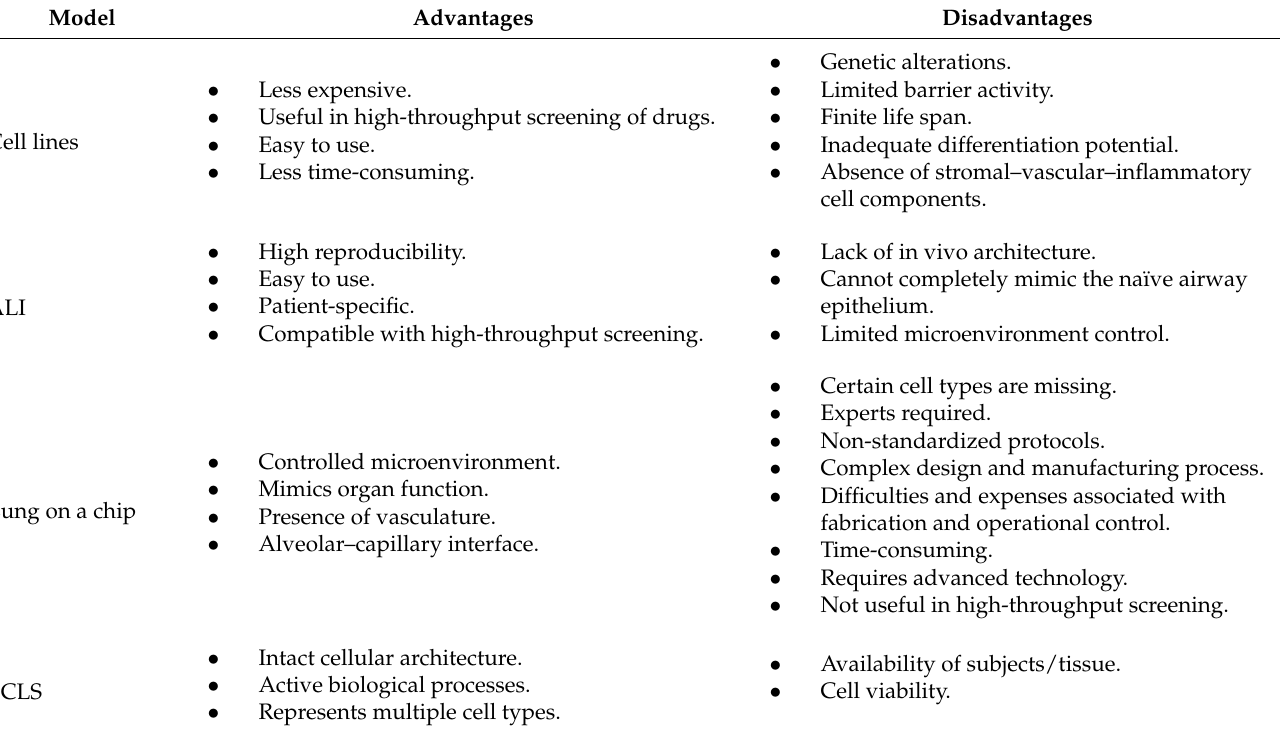
Figure 4. Models to study the effect of smoking on lung diseases: Types of different 2D in vitro (cell culture) , 3D in vitro (Spheroids, ALI, and lung-on-a-chip), ex vivo (PCLS, organoids), and in vivo (animal) models to study the effect of smoking on lung disease pathophysiology. Table 3. Models used in smoking studies.